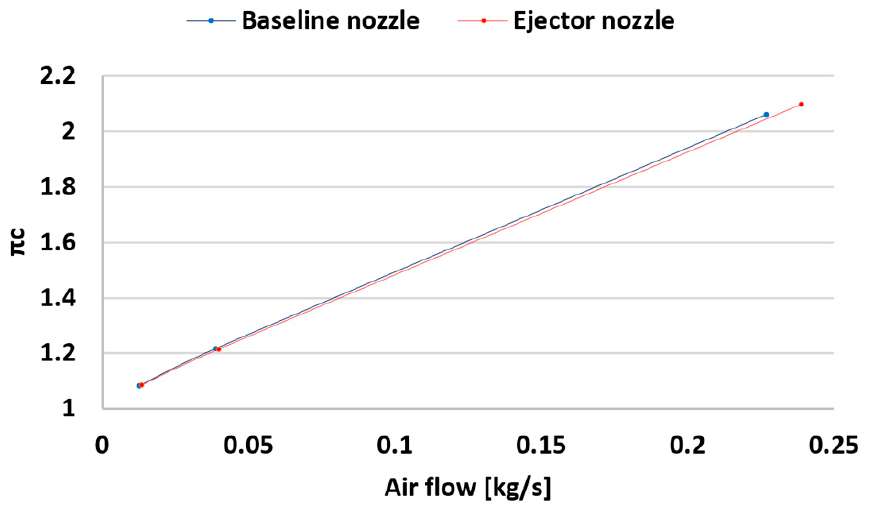
Figure 20. Engine operating line.